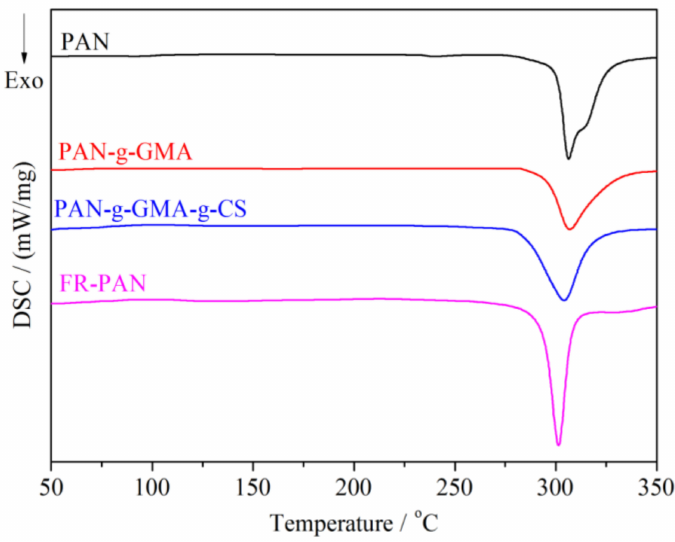
Figure 4. DSC curves of PAN and modified PAN